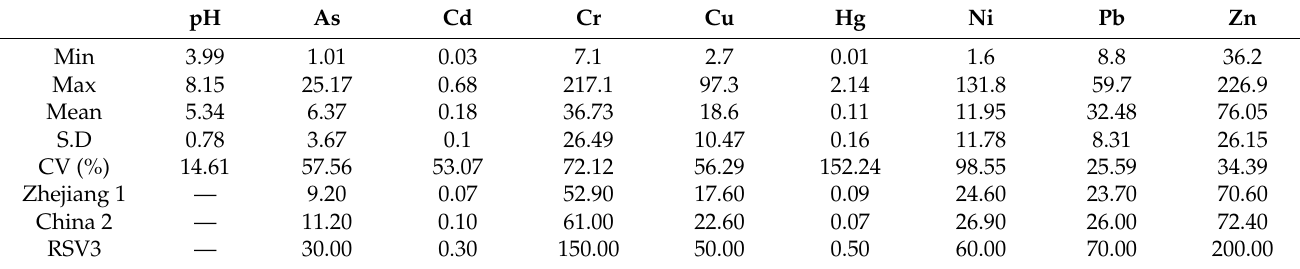
Table 1. Statistical description of soil heavy metals concentrations in the agricultural land of Jinhua City (mg kg − 1 ).